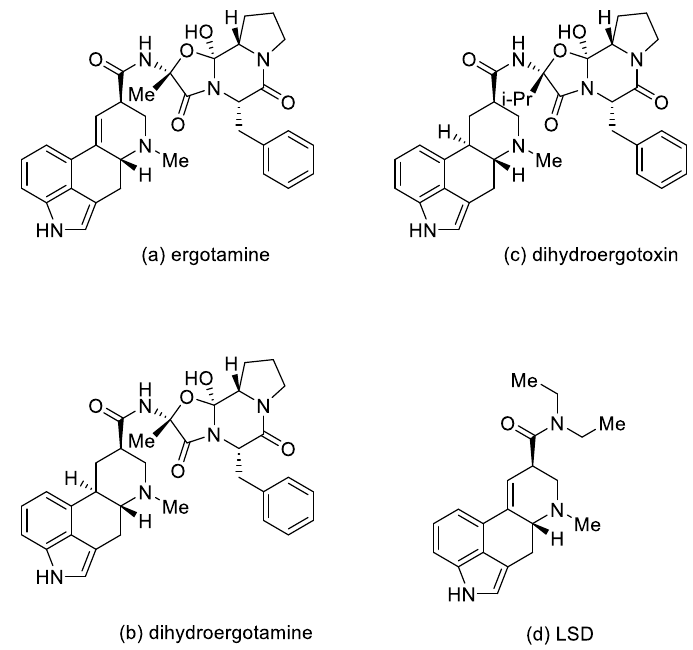
Figure 4. Ergot alkaloid derivatives.